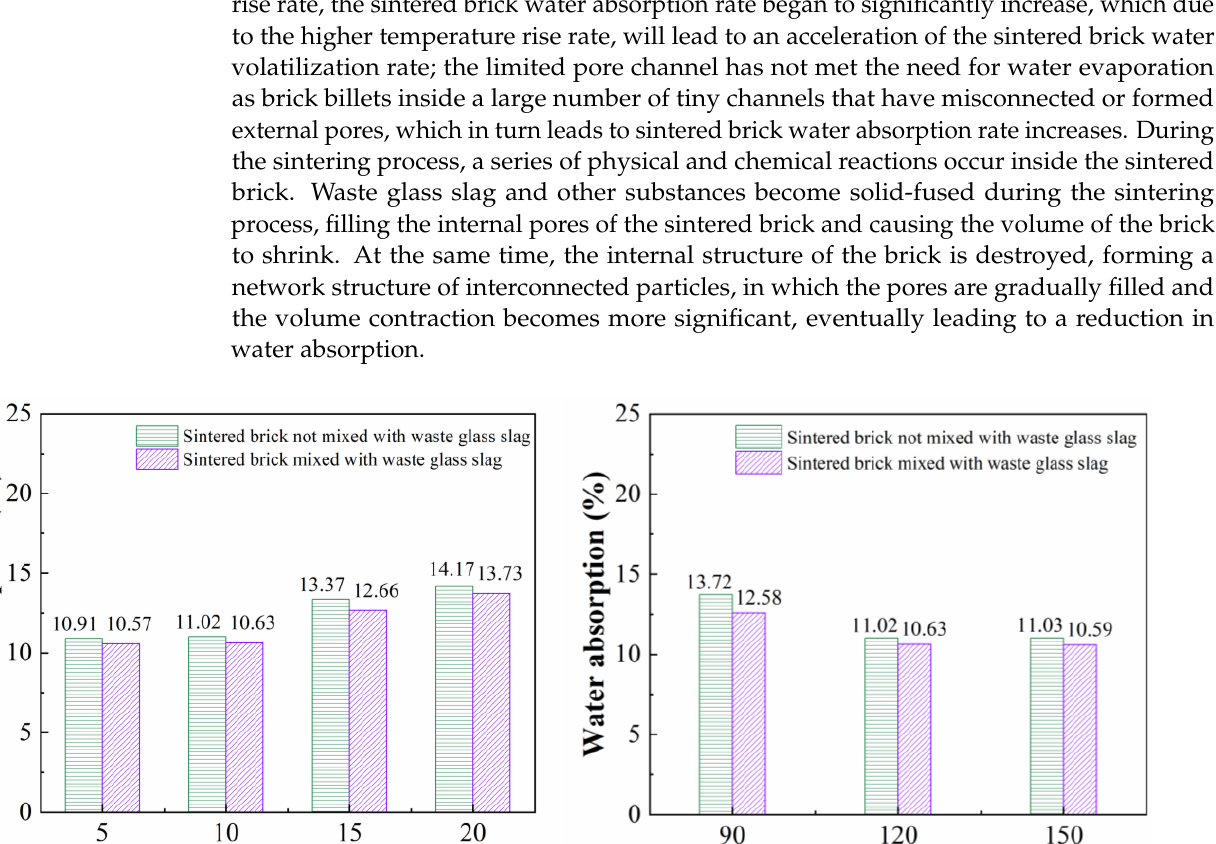
Figure 10. Effect of sintering temperature on water absorption of MGB sintered brick.